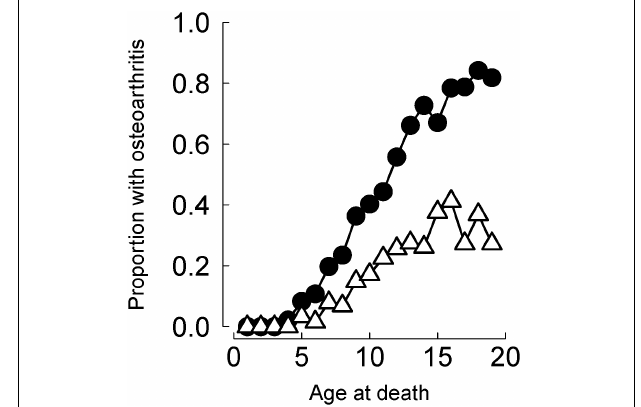
FIGURE 1 | The proportion of moose exhibiting any sign of osteoarthritis (black circles) and severe osteoarthritis (white triangles) at the time of death increases with age in a population of moose in Isle Royale National Park. Dataset is based on necropsies of 1,571 moose that died between